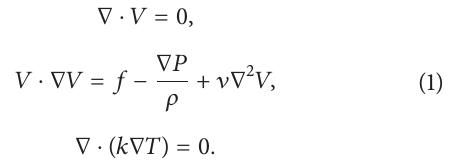
midplane) inclined at 45